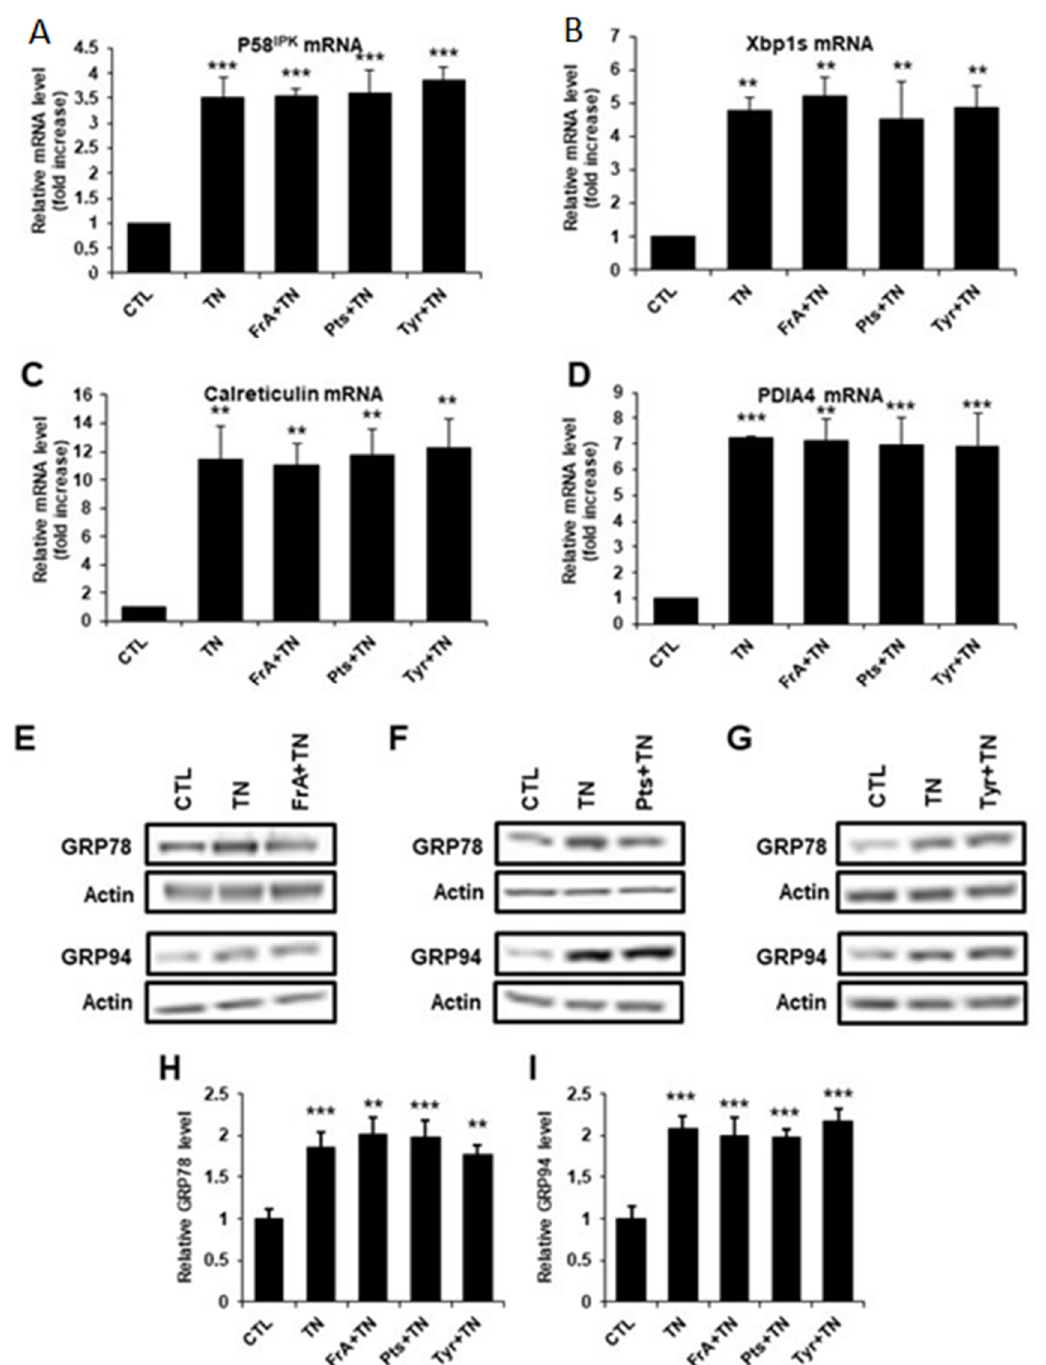
Figure 7. Ferulic acid, pterostilbene, and tyrosol do not modulate the IRE1 or the ATF6 pathway of the UPR in response to severe ER stress. H9c2 cells were pre-treated for 1 h with ferulic acid (FrA, 5 µM), pterostilbene (Pts, 0.5 µM), or tyrosol (Tyr, 1 µM), and then wer3e treated for 6 h with tunicamycin (TN, 10 µg/mL), and the relative mRNA levels of the IRE1 pathway target genes P58 IPK ( A , n = 4) and Xbp1s ( B , n = 4), and the ATF6 pathway target genes Calreticulin ( C , n = 4) and PDIA4 ( D , n = 3), were quantified by qPCR. The protein levels of the GRP78 and GRP94 chaperones were analyzed by western blot after 36 h. Representative western blots under ferulic acid ( E ), pterostilbene ( F ), or tyrosol ( G ) treatment are presented. Bar graphs show the quantitative western blot analysis for the GRP78 ( H , n = 5) and GRP94 ( I , n = 5) proteins. Actin was used as a loading control. Values represent mean ± S.E.M. ** p < 0.01, *** p < 0.001 vs. control.